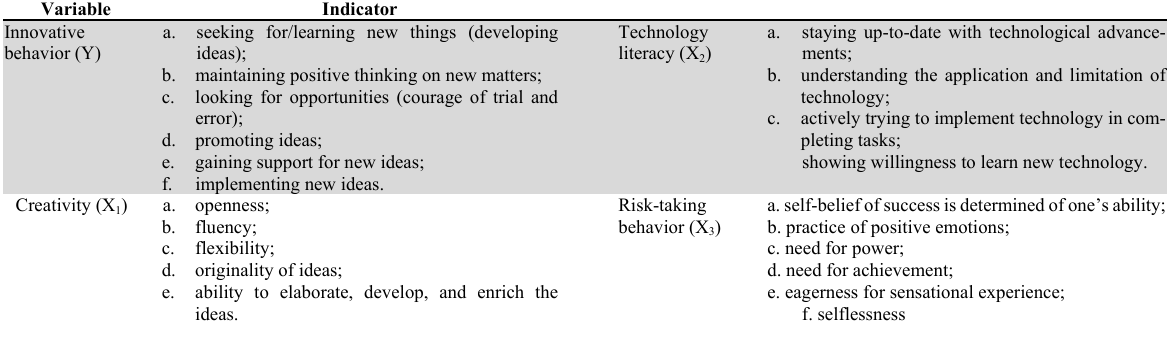
Variable and Indicator of Research Variable Indicator